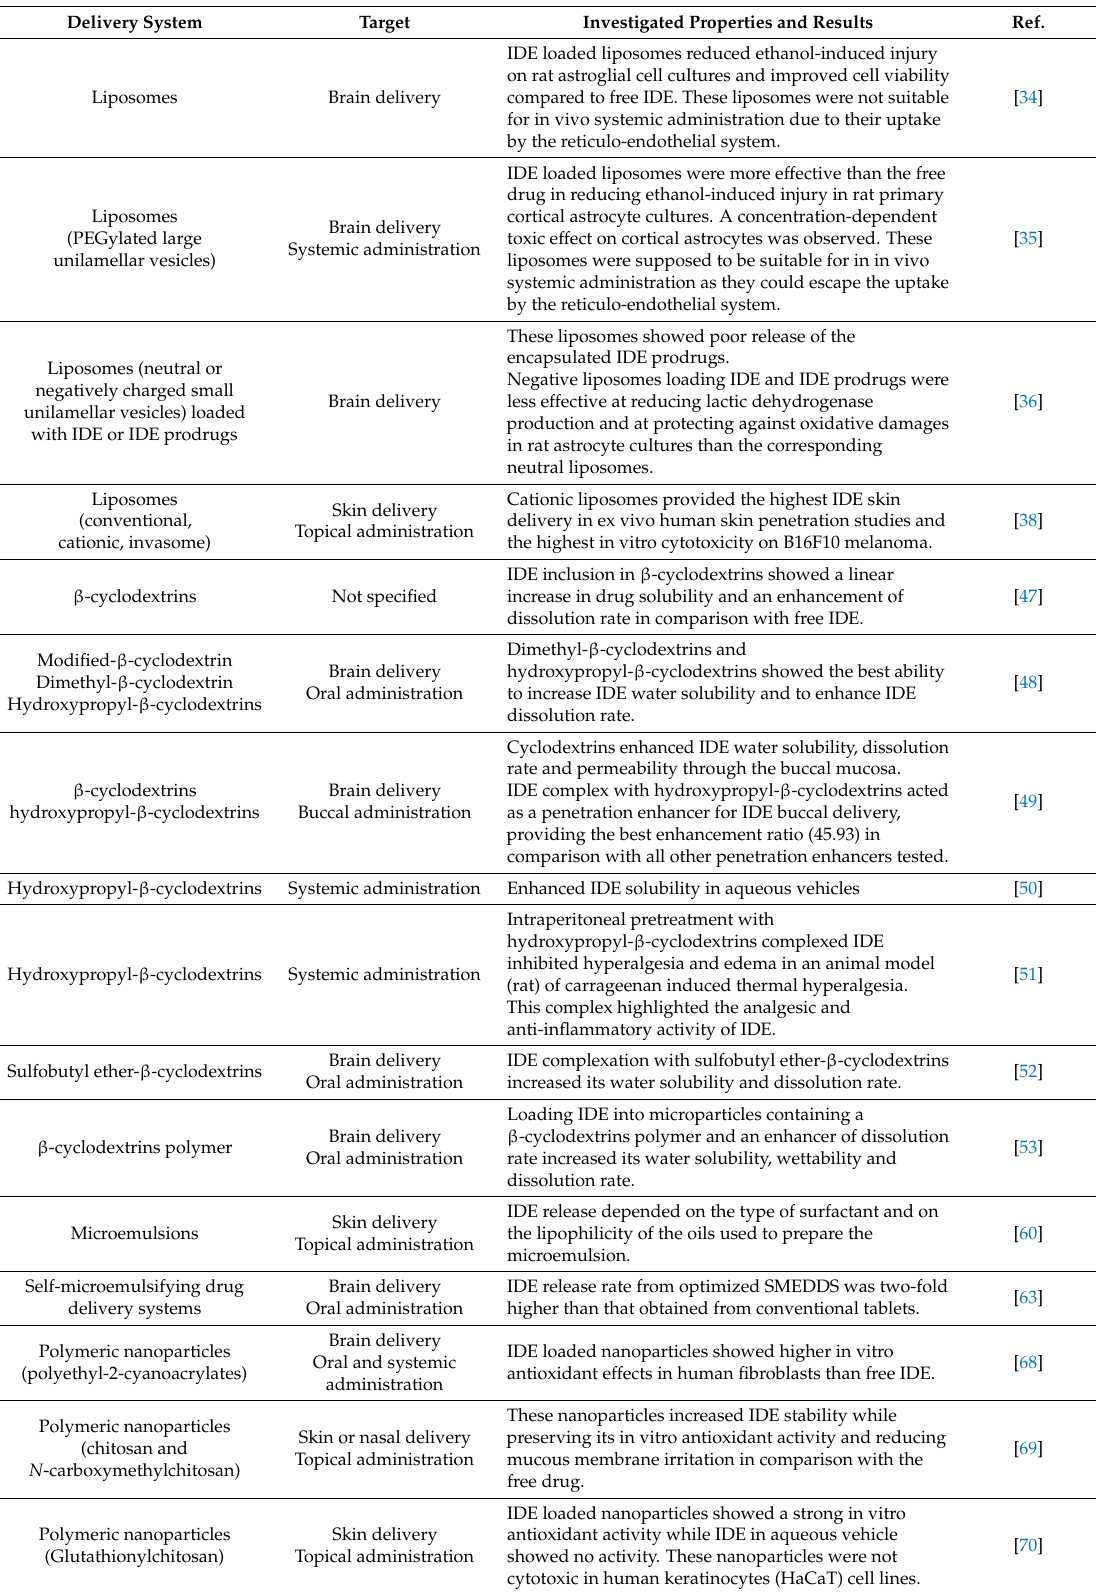
Table 1. Idebenone (IDE) delivery systems investigated to date. Ref. =